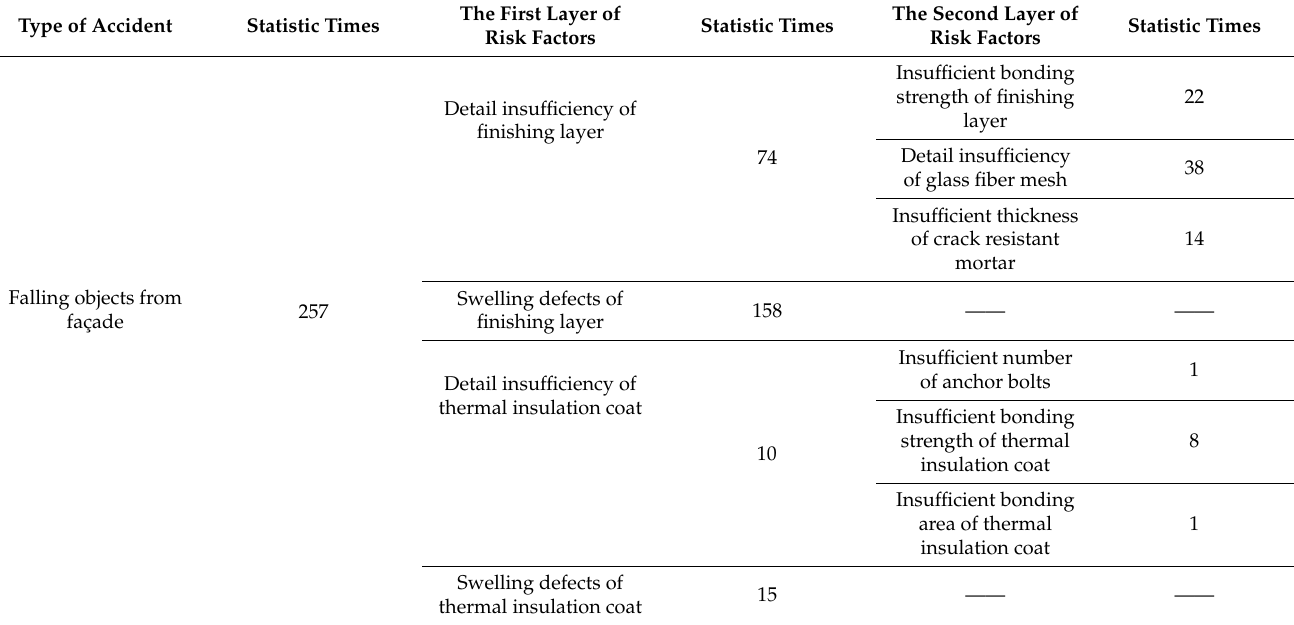
Table 2. Hierarchical analysis and statistics of the risk of falling objects from